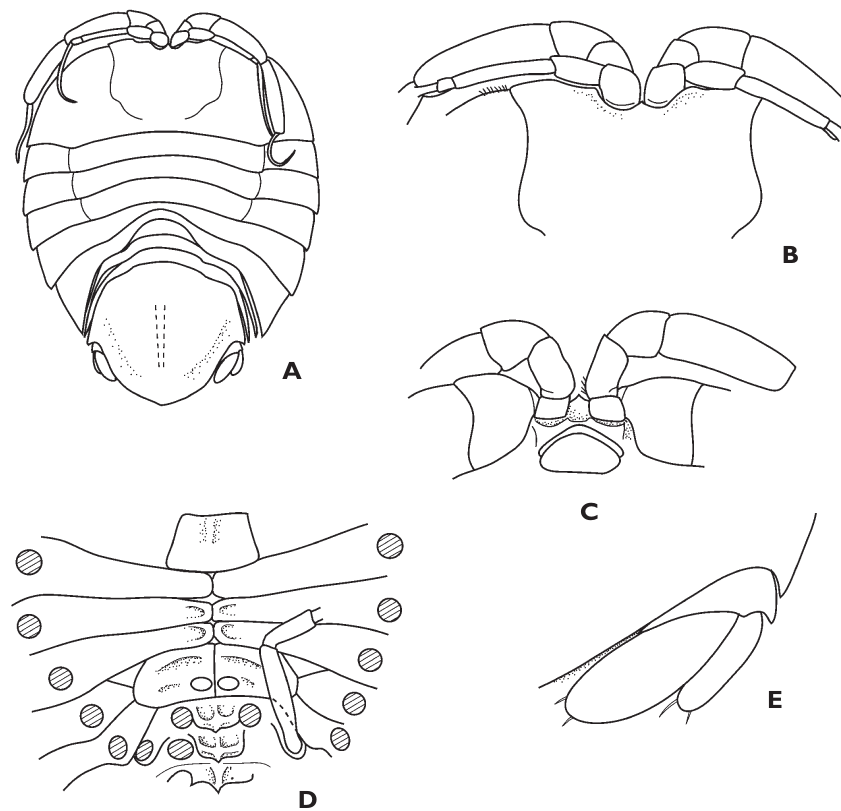
Figure 28. Caecoserolis brinki (Kensley, 1978). Holotype. A dorsal view B head, anterolateral margin C frons D ventral view sternites and pleonites E uropods (in